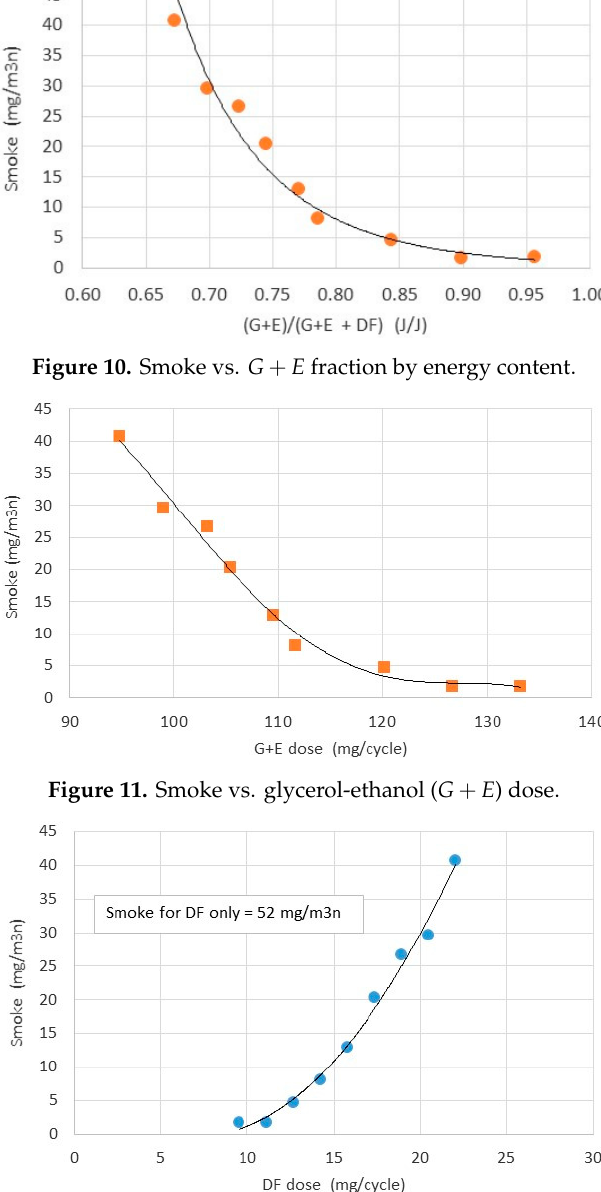
Figure 12. Smoke vs. diesel fuel ( 𝐷𝐹 ) pilot dose.